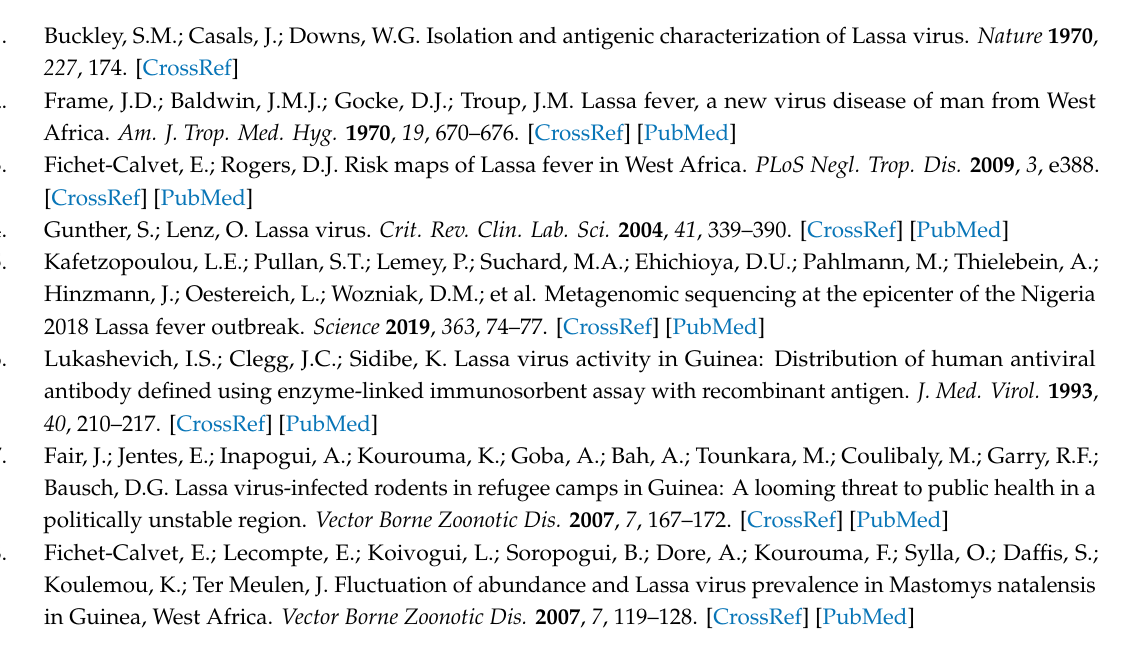
Figure S1: Phylogenetic analyse done with partial nucleoprotein (630 nt), including 45 sequences. Four sequences published in Bowen et al. 2000 were added to the main analysis to support four sub-lineages: Faranah, Kissidougou, Macenta and Nz é r é kor é , Table S1: List of patients and contacts tested for Ebola (EBOV) and Lassa (LASV)